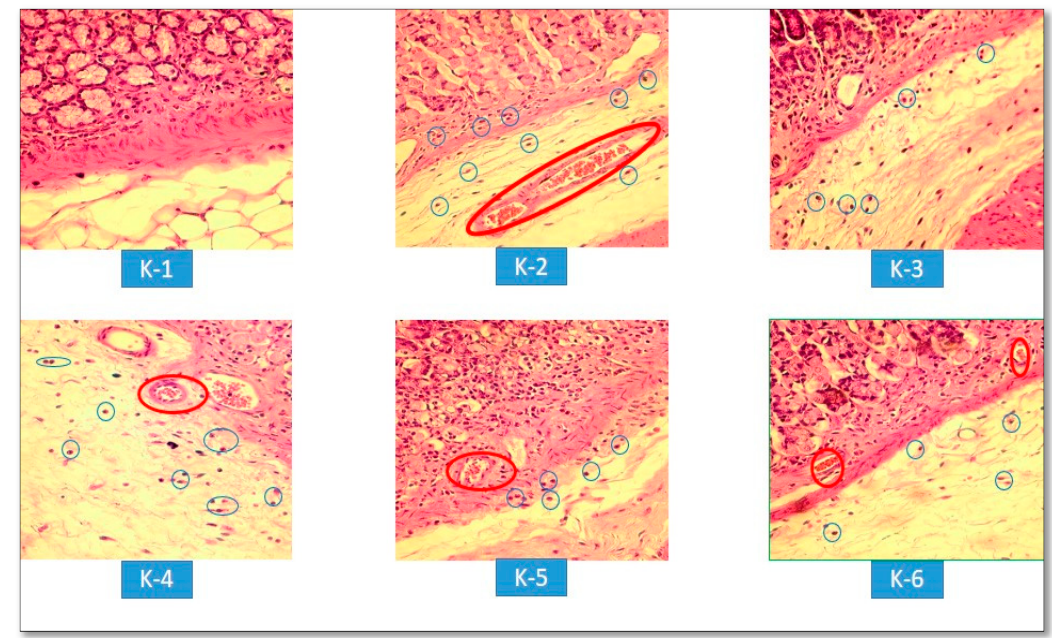
Figure 4. Microscopic result infiltration of inflammation cells and congestion: K-1, Normal group; K-2, Negative control group (CMC); K-3, Positive control group (OMZ); K-4, Rice Bran Extract group 100 mg/kg BW; K-5, Rice Bran Extract group 200 mg/kg BW; and K-6, Rice Bran Extract group 400 mg/kg BW) (magnification 400 × ). Infiltration of inflammatory cells (neutrophils); = Congestion.